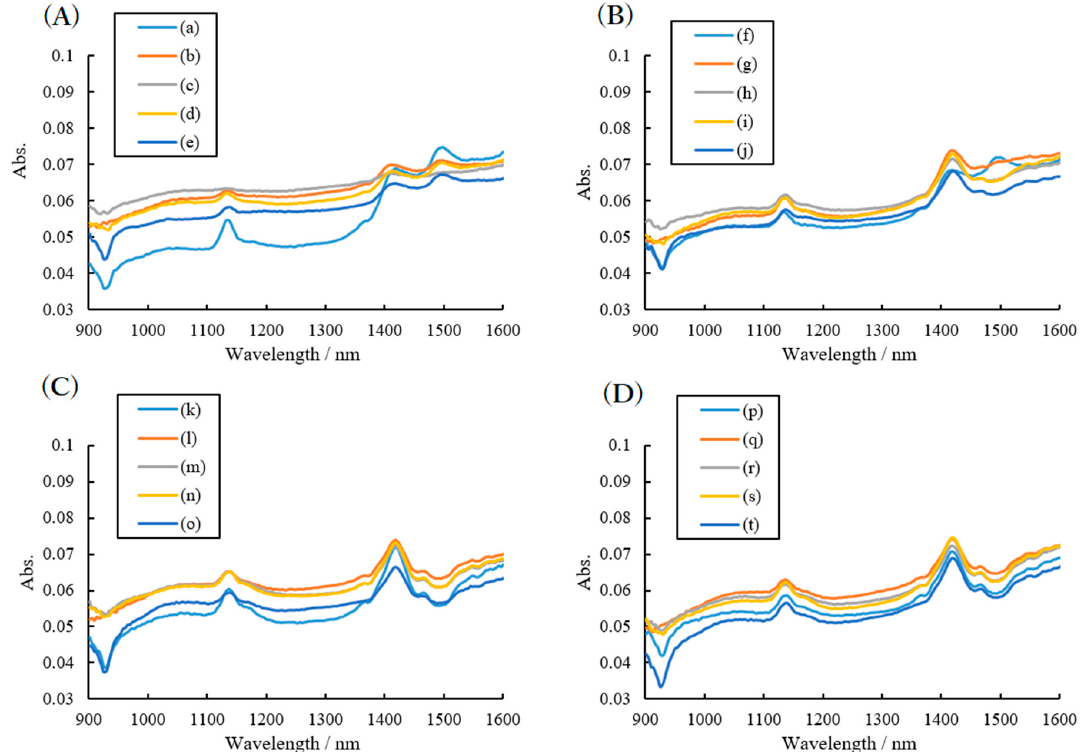
Figure 4. Near-infrared spectra of stored samples. Ground RB sample stored in RH 30% ( A ) and RH 75% ( B ). Bulk RB sample stored in RH 30% ( C ) and RH 75% ( D ). Storage time: 0 weeks (a, f, k, and p); 1 week (b, g, l, and q); 2 weeks (c, h, m, and r); 3 weeks (d, i, n, and s); 4 weeks (e, j, o, and t). RH;